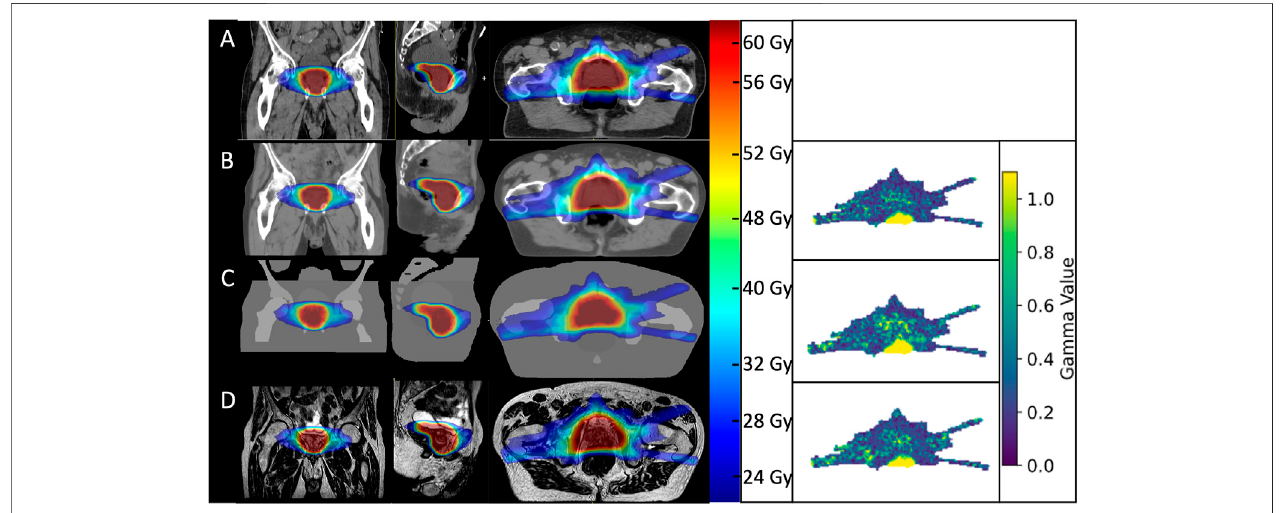
FIGURE4| VisualcomparisonofdosedistributionsbetweenthegoldstandardCTplan (A) ,AICT (B) ,PBCT (C) ,andPSCT (D) visualizedovertheusedMRIforthe patient with the lowest performing gamma pass rates. On the right side, the corresponding gamma maps for a 2 mm/2% criterion.